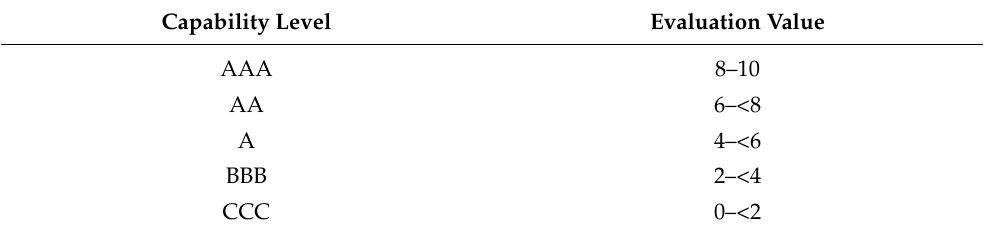
Table 2. Evaluation criteria for emergency